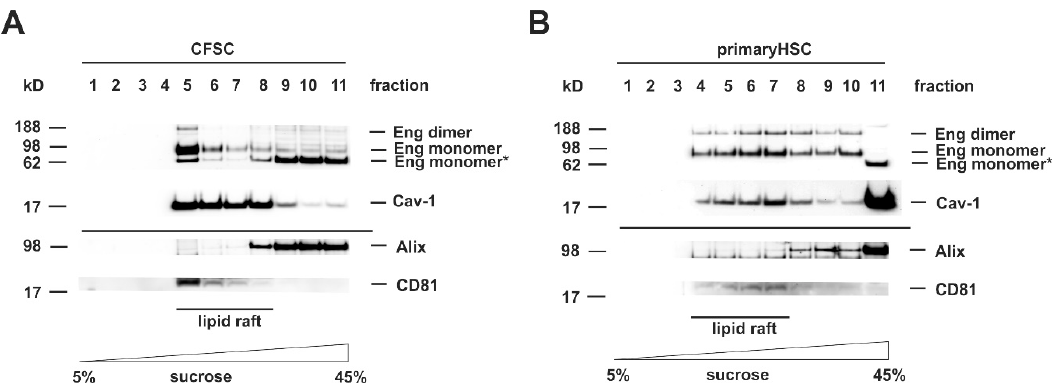
Figure 1. Endoglin is localized in Caveolin-1 enriched lipid rafts. ( A ) CFSC and ( B ) primary rat hepatic stellate cells (HSC) were cultured to near confluence under basal conditions (10% FCS). Thereafter, the cells were harvested in carbonate buffer, sonicated, and the extracts separated on a sucrose gradient. Eleven consecutive fractions were collected starting from the top (low sucrose) to the bottom (high sucrose). Proteins of the individual fractions (equal volumes) were separated by SDS-PAGE and analyzed by Western blot analysis. Lipid rafts were identified by detection of Caveolin-1. The presence of Endoglin (Eng), Alix, and CD81 were analyzed by specific